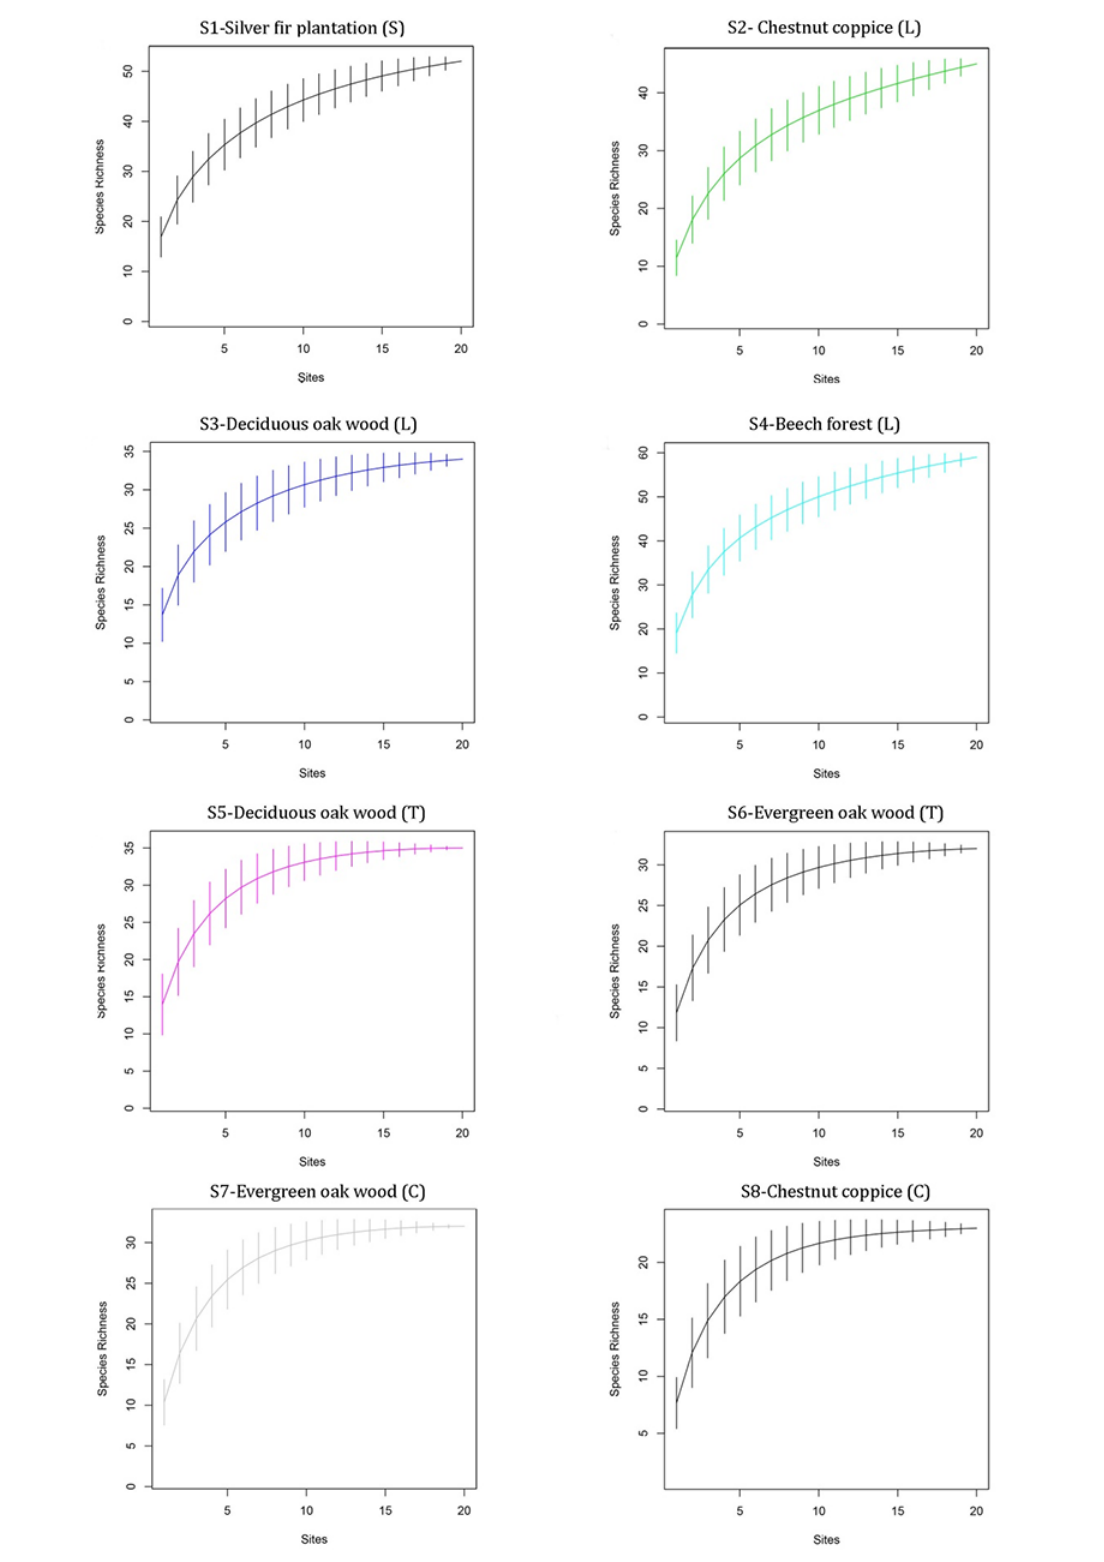
Figure 2 e rarefaction curves for all the study sites (S1–S8). “Sites” in the graphs refer to surveyed plots in each site. (S) – Sardinia; (L) – Liguria; (T) – Tuscany; (C) – Campania.